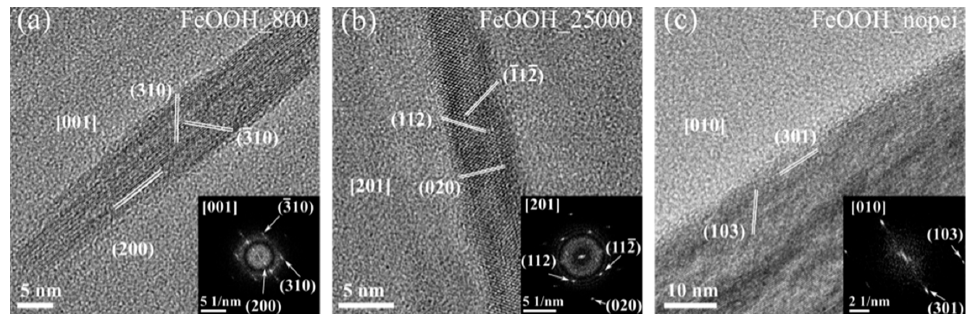
Figure 2. HRTEM images and corresponding 2-dimensional fast Fourier transform (2D-FFT) patterns of β -FeOOH nanoparticles (NPs) prepared with low M w polyethylenimine (PEI) ( a ); with high M w PEI ( b ); and without PEI (c).